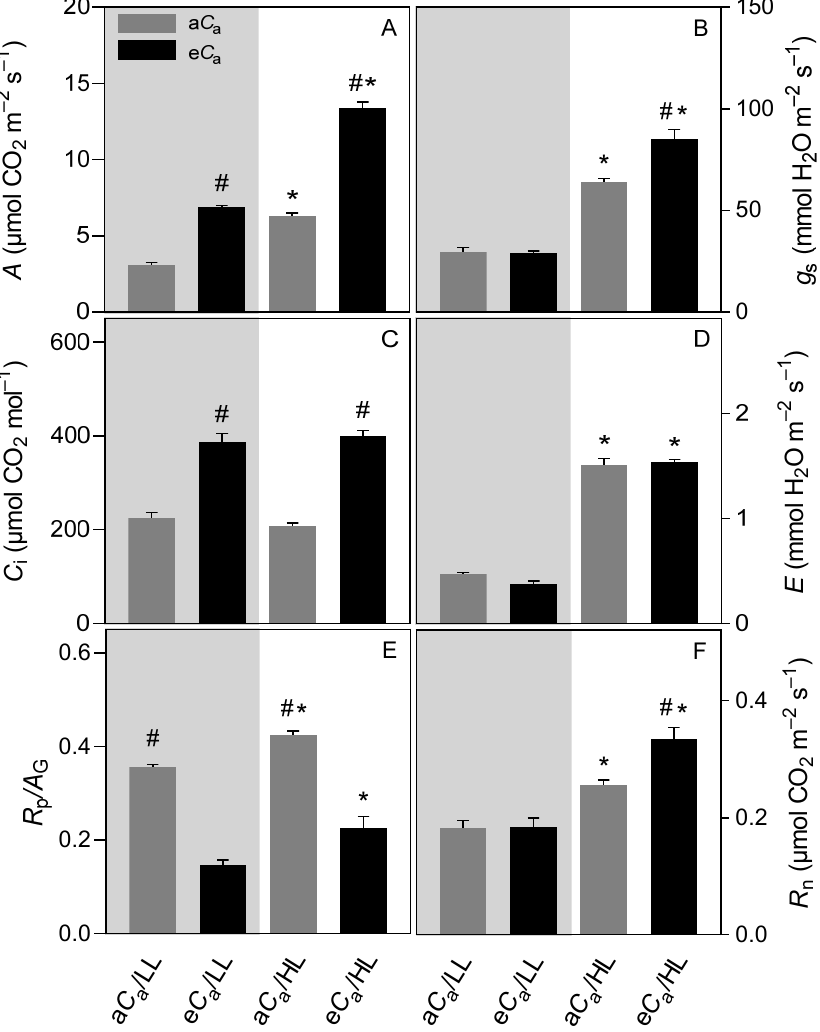
Figure 1. The effect of light intensity [low (grey area) or high (white area) light] and CO 2 supply [am- bient (a C a ) or elevated (e C a ) supply] on ( A ) net carbon assimilation rate ( A ), ( B ) stomatal conductance ( g s ), ( C ) internal CO 2 concentration ( C i ), ( D ) transpiration rate ( E ), ( E ) photorespiration-to- gross photosynthetic rate ratio ( R p / A G ), and ( F ) nocturnal respiration ( R n ). Asterisk (*), when shown, indicates di ff erences between light regimes within the same CO 2 supply. Pound (#), when shown, indicates di ff erences between CO 2 treatments within the same light regime ( p ≤ 0.05, F test, n = 6 ± SE).